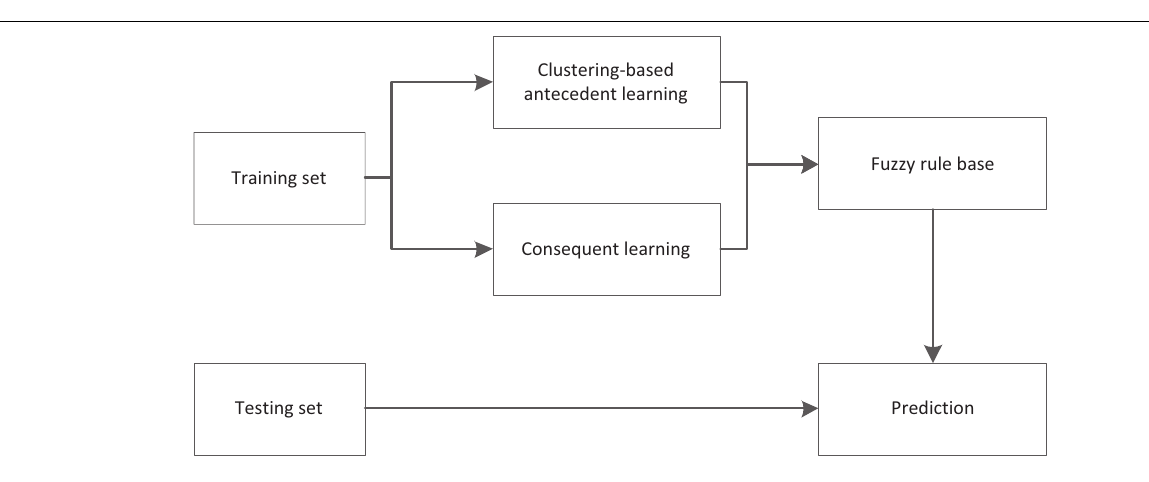
FIGURE 1 | Data preprocessing pipeline of positron emission tomography (PET) images.